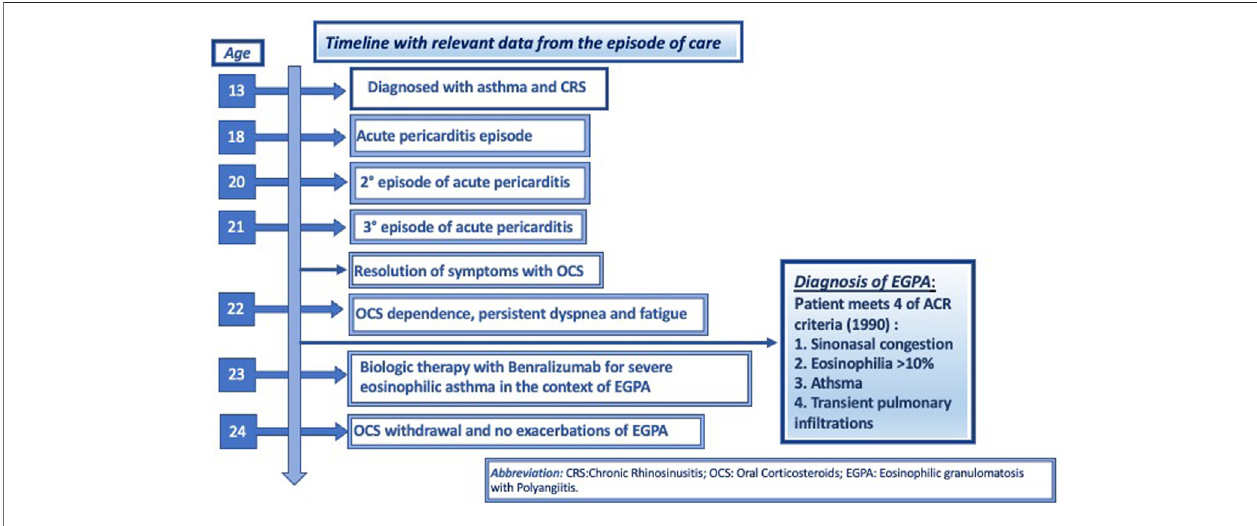
FIGURE 1 | Timeline with relevant data from the episode of care, according to CARE case report guidelines.